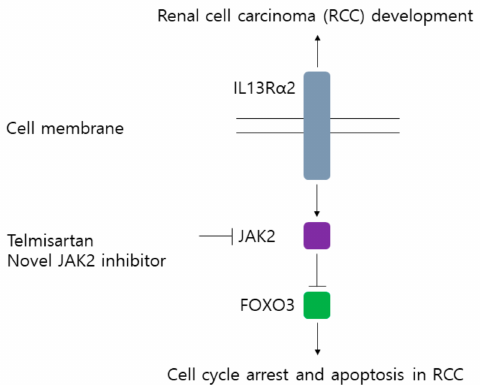
Figure 6. A diagram for the possible oncogenic role of IL13R α 2 in renal cell carcinoma (RCC) by activation of JAK2 and inhibition of